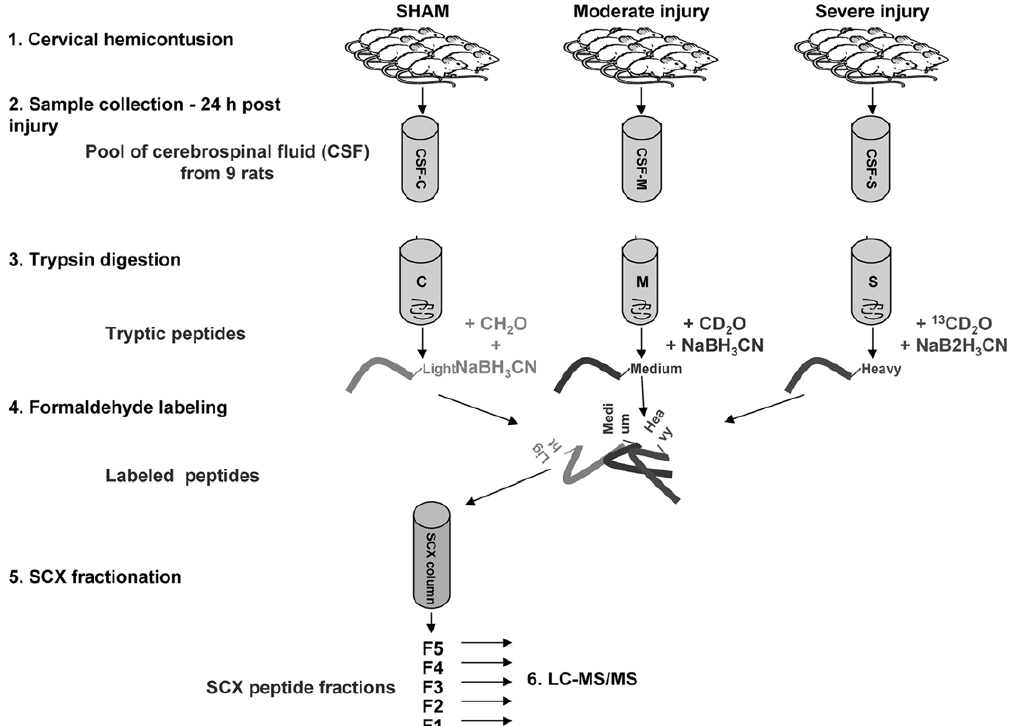
Figure 1. Experimental Outline.